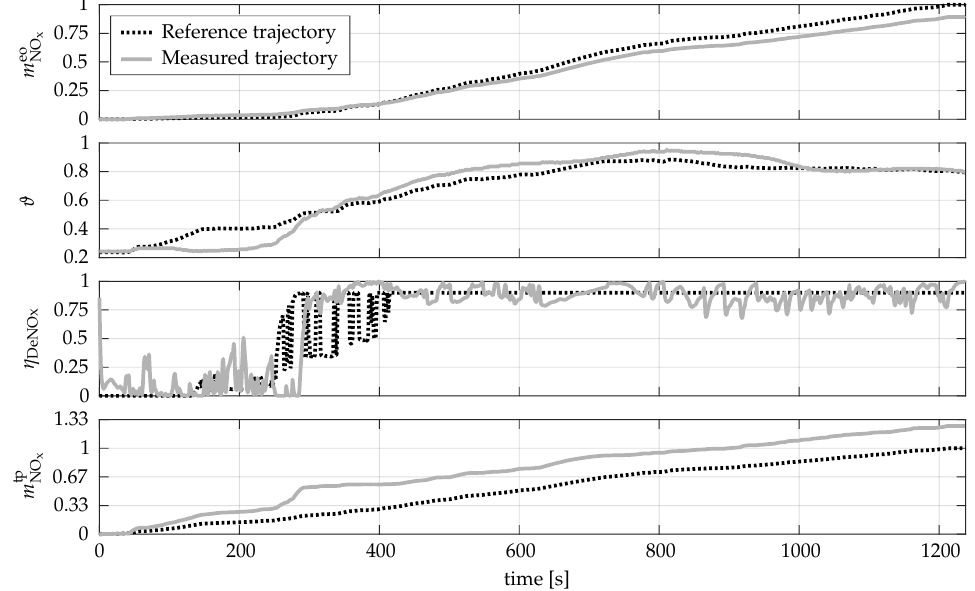
Figure 4. Comparison of the reference trajectories resulting from solving optimal control prob- lem (10a–i) (dotted black) and the corresponding measured trajectories obtained by applying the input trajectories in a feedforward fashion (solid gray) for the NRTC with ϑ ( 0 ) = 100 ◦ C. All values were normalized.